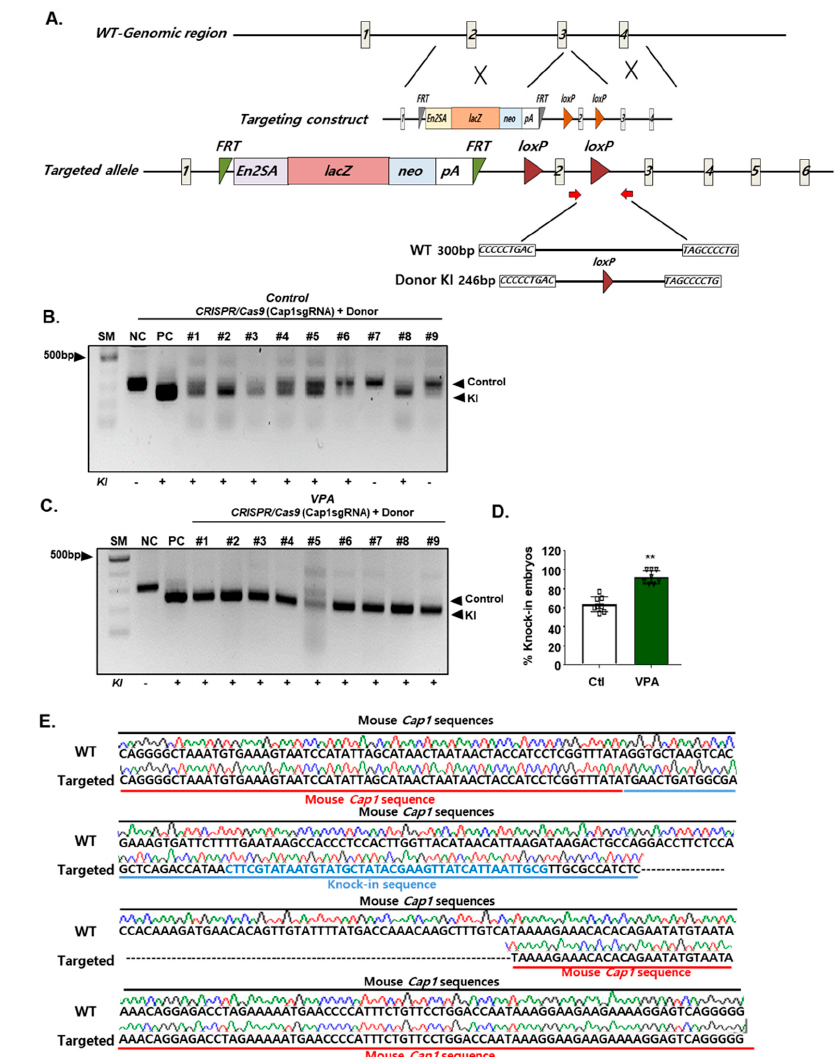
Figure 3. VPA enhances CRISPR/Cas9 ‐ mediated knock ‐ in efficiency in mouse embryos. ( A ) Schematic illustration depicting the targeting strategy for the Cap1 locus. Primers used for PCR analysis are represented by red arrows. En2SA: splice acceptor site of exon 2 of the mouse engrailed ‐ 2 gene. LacZ: β‐ galactosidase; Neo: neomycin ‐ resistance. ( B ) Representative separation of Cap1 PCR products in the mouse embryos CRISPR/Cas9 ‐ targeted without VPA ‐ treatment after 3.5 days of injection. The upper and lower arrows indicate the PCR fragments without (300 bp) and with (246 bp) Cap1 knock ‐ in donors, respectively. ( C ) Representative of Cap1 PCR products in the mouse embryos CRISPR/Cas9 ‐ targeted with VPA ‐ treatment. ( D ) The knock ‐ in efficiency in the mouse embryos evaluated using PCR. Data were expressed as mean ± SD, n = 3. ** p < 0.01, two ‐ sided Student’s t ‐ test. ( E ) Sanger sequencing of knock ‐ in mouse Cap1 locus. Blue colored sequences are loxP knock ‐ in sequences. The images in B and C are representatives of ≥ 3 similar experiments.